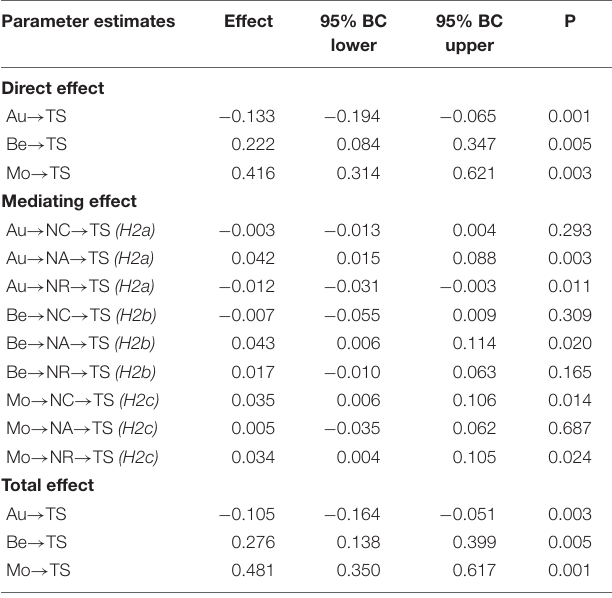
TABLE 4 | Standardized results of direct effects and mediating effects on trust in